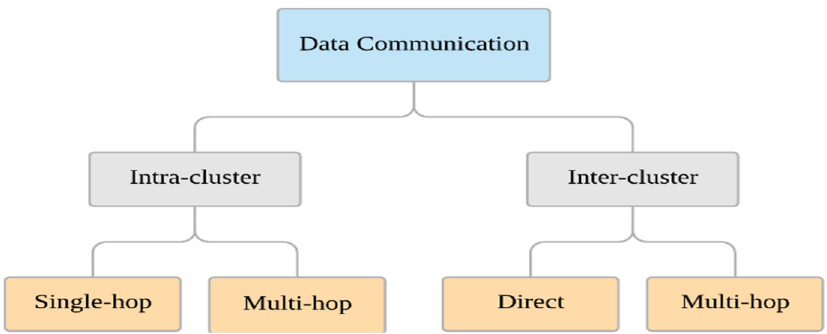
Figure 9. Data communication phase process.